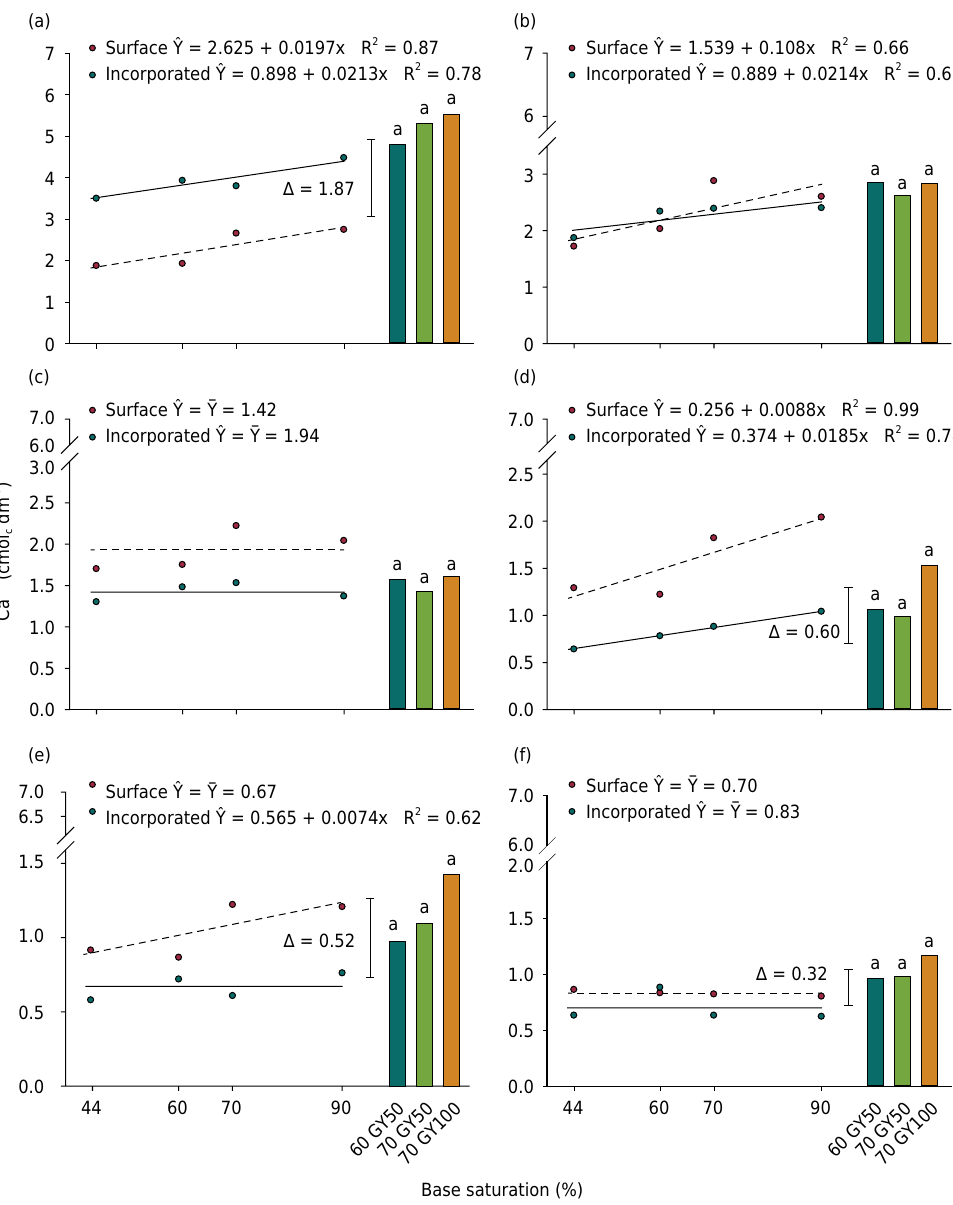
Figure 4. Calcium (Ca 2+ ) content after reapplication of lime and phosphogypsum at different layers (m): 0.00-0.05 (a), 0.05-0.10 (b), 0.10-0.20 (c), 0.20-0.30 (d), 0.30 -0.40 (e), and 0.40-0.60 (f). Different letters above the bars indicate a significant difference between the treatments with phosphogypsum based on Tukey’s test (p<0.05). The vertical bar indicates the DMS between each factorial vs additional treatment based on a Dunnett test (p<0.10). An F test revealed a significant difference between the modes of lime application to the layers presented in figures 1a (p<0.00), 1c (p<0.01), 1d (p<0.00), 1e (p<0.00), and 1f